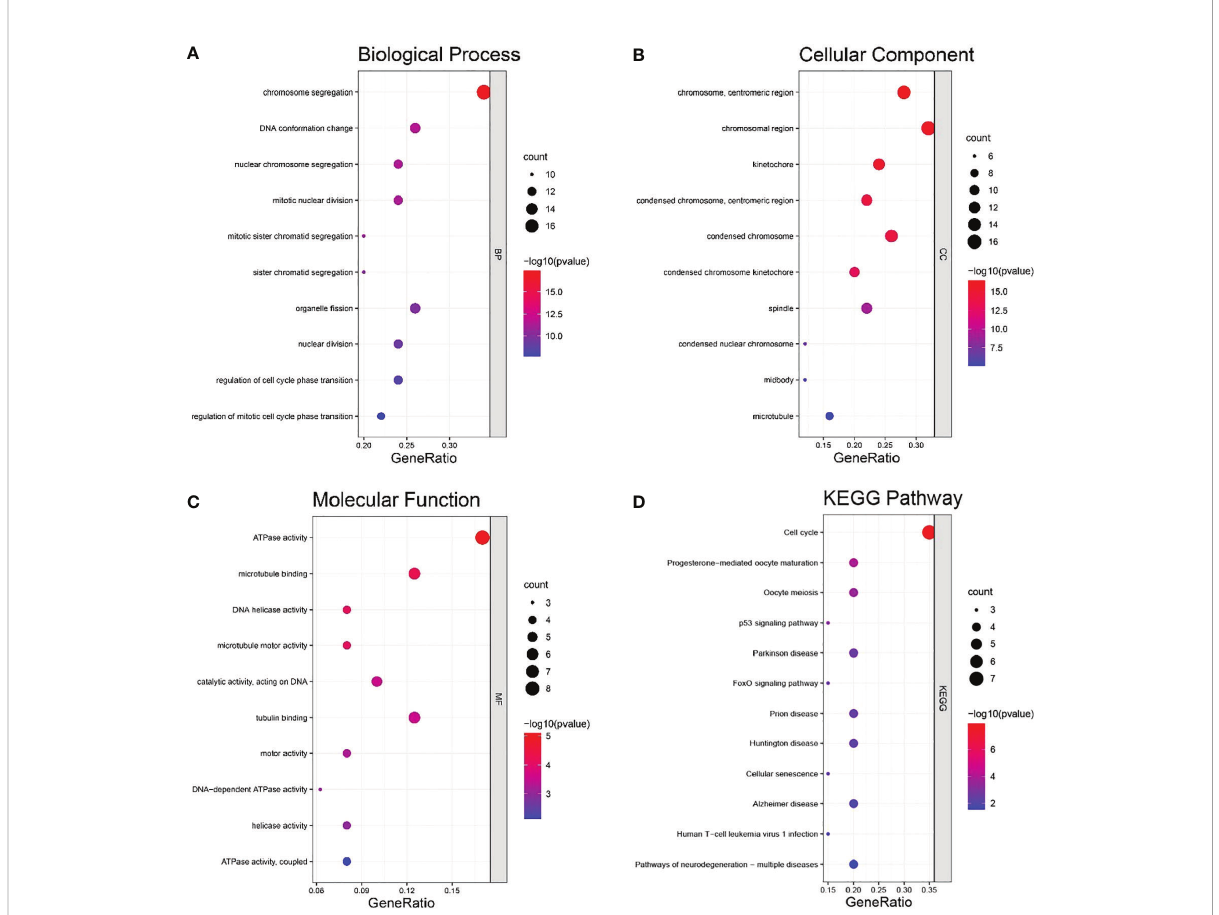
FIGURE 7 Coexpressed genes for HMGB3 were analyzed for GO and KEGG enrichment analyses. (A) Analysis of positively connected genes ’ GO BP enrichment. (B) Analysis of positively associated genes ’ GO CC enrichment. (C) Analysis of positively linked genes ’ GO MF enrichment. (D) Enrichment analysis of KEGG pathways for the positively related